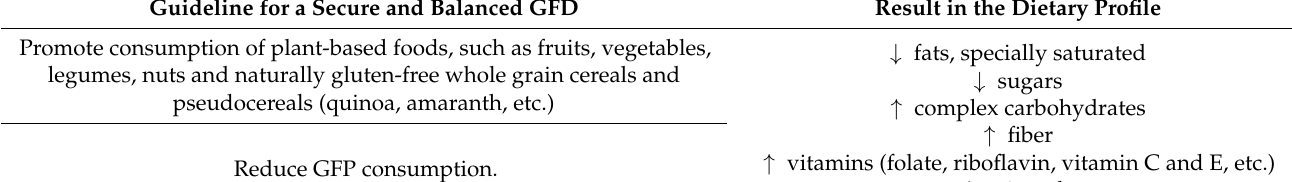
Table 6. Dietary guidelines for a balanced GFD. Guideline for a Secure and Balanced GFD Result in the Dietary